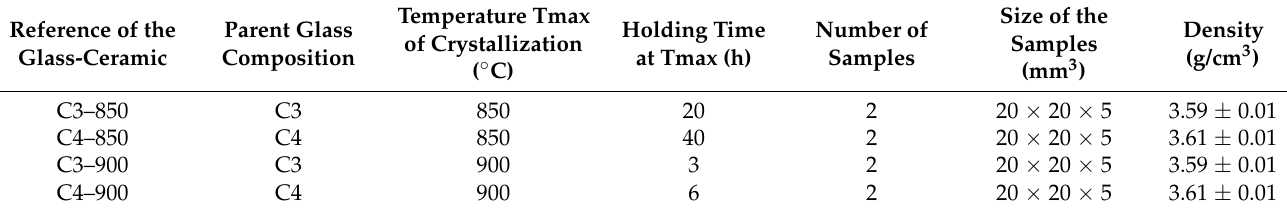
Table 5. Conditions of synthesis of the glass-ceramic samples.